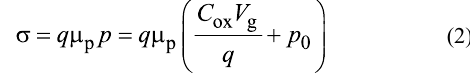
By linear fitting of the data in Figure 4c by Equation 1, the sheet resistance ( R sh = 1.75 ± 0.04 k Ω /sq) and the contact resis- tance ( R c = 75 ± 6 Ω ) contributions have been